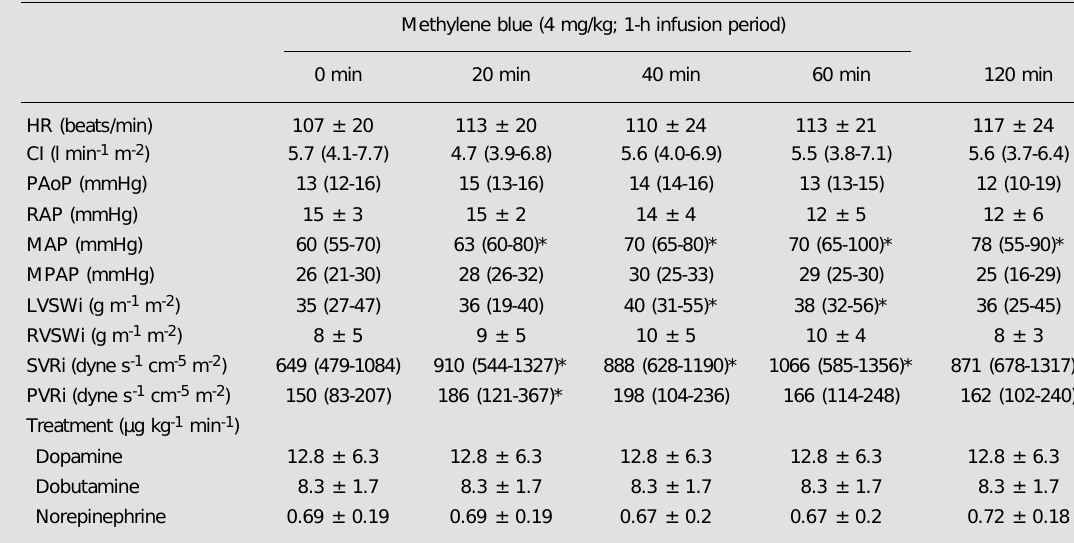
Table 2 - Time course of hemodynamic